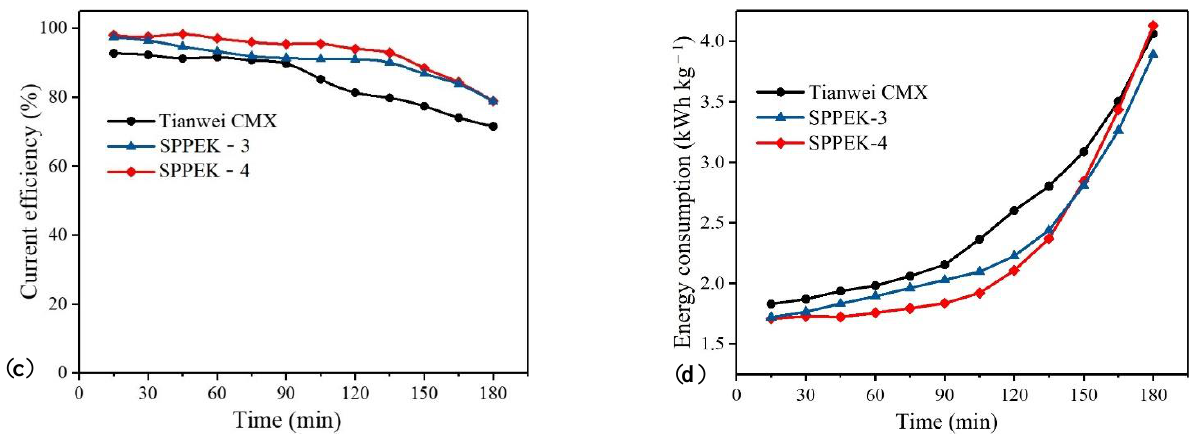
Figure 9 . The ED performance of SPPEK-3, SPPEK-4, and CMX membranes; ( a ) ion conductivity of standard solution in DC and CC; ( b ) the final salt removal rate; ( c ) current efficiency; ( d ) energy consumption of ED equipment.